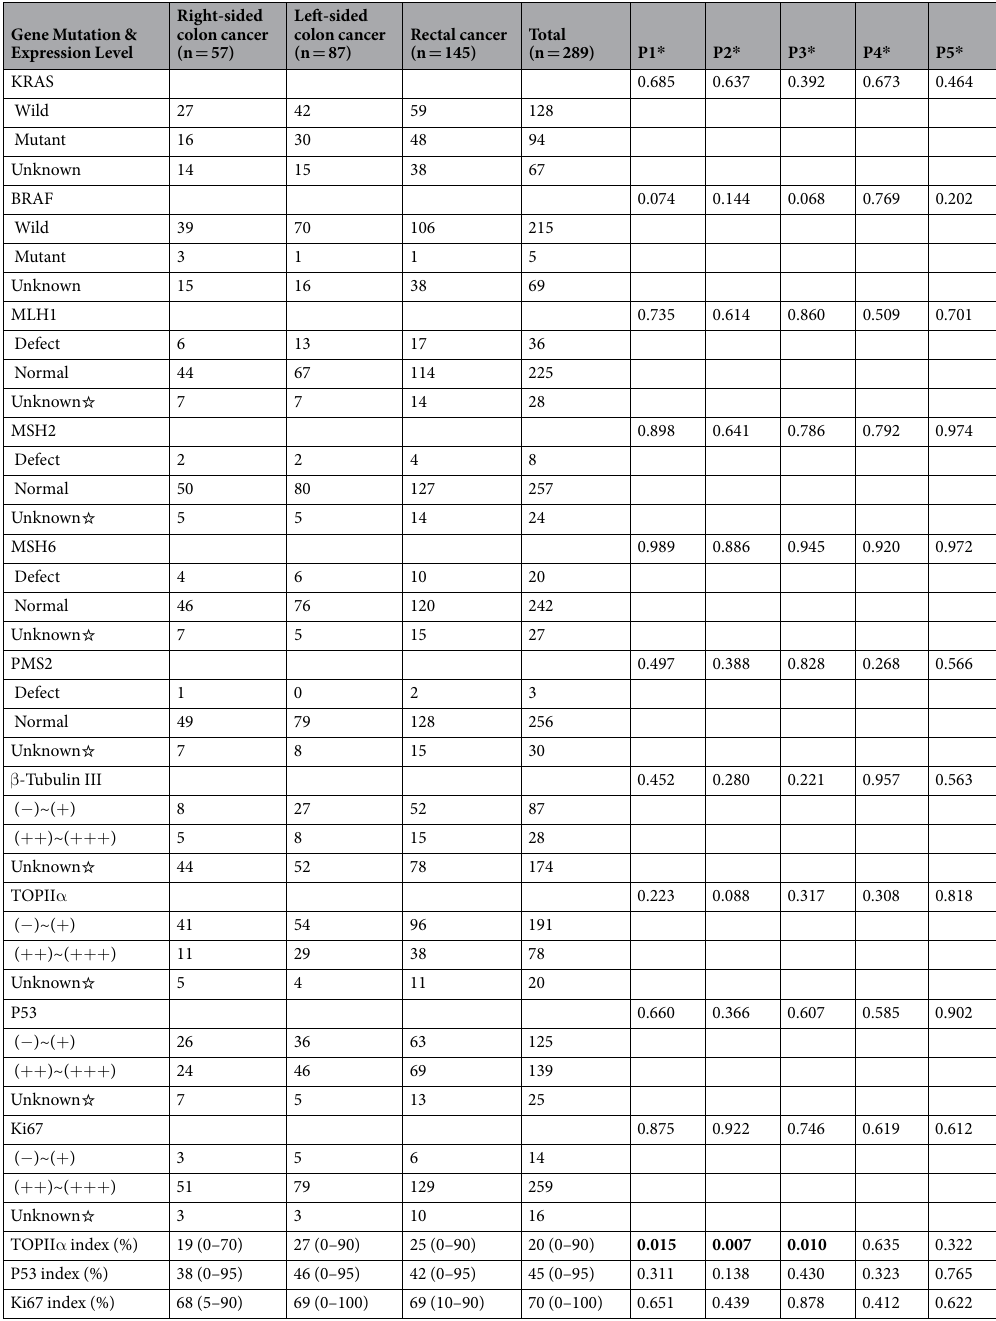
Table 4. Relationship between Tumor Position and Gene Mutation, Protein Expression Levels in 289 Colorectal Cancer Patients. # RSCC: Right-sided colon cancer; ▴ LSCC: Left-sided colon cancer; * P1: comparison of three group; P2: RSCC vs. LSCC; P3: RSCC vs. rectal; P4: LSCC vs. rectal; P5:colon vs. rectal; ☆ All of the “Unknown” groups were not taken into analysis in this